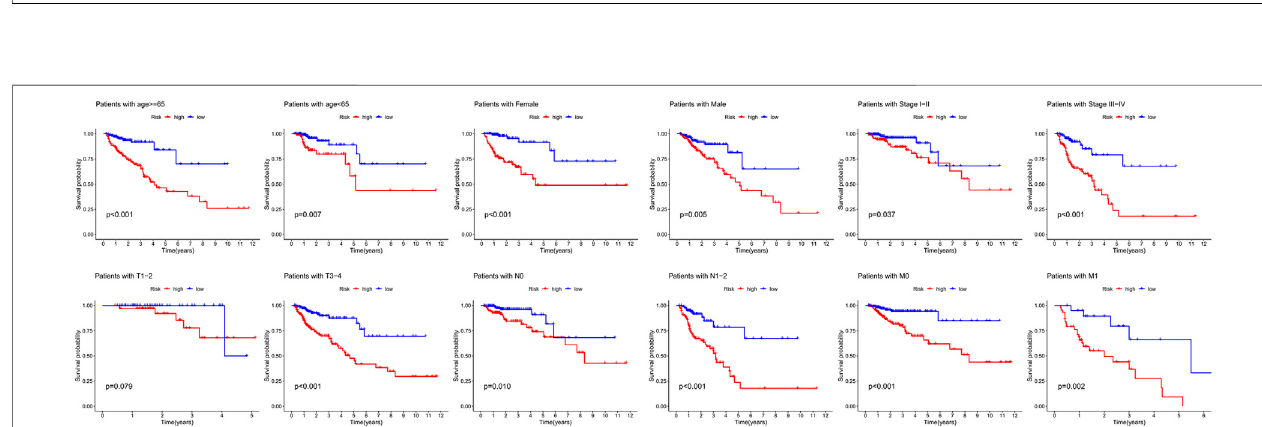
FIGURE 4 | Survival differences between high- and low-risk CRC patients strati fi ed by clinical factors.